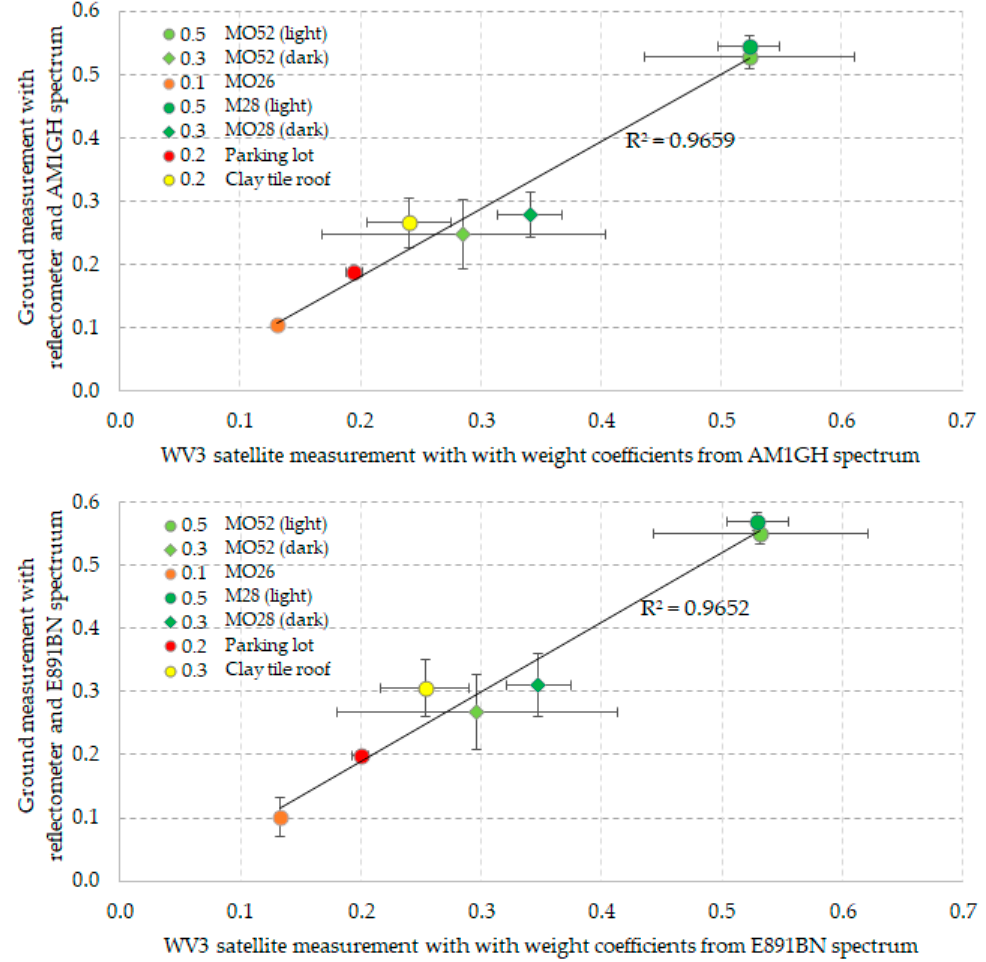
Figure 7. Comparison between ground and satellite solar reflectance measurement with E891BN and AM1GH reference spectra.